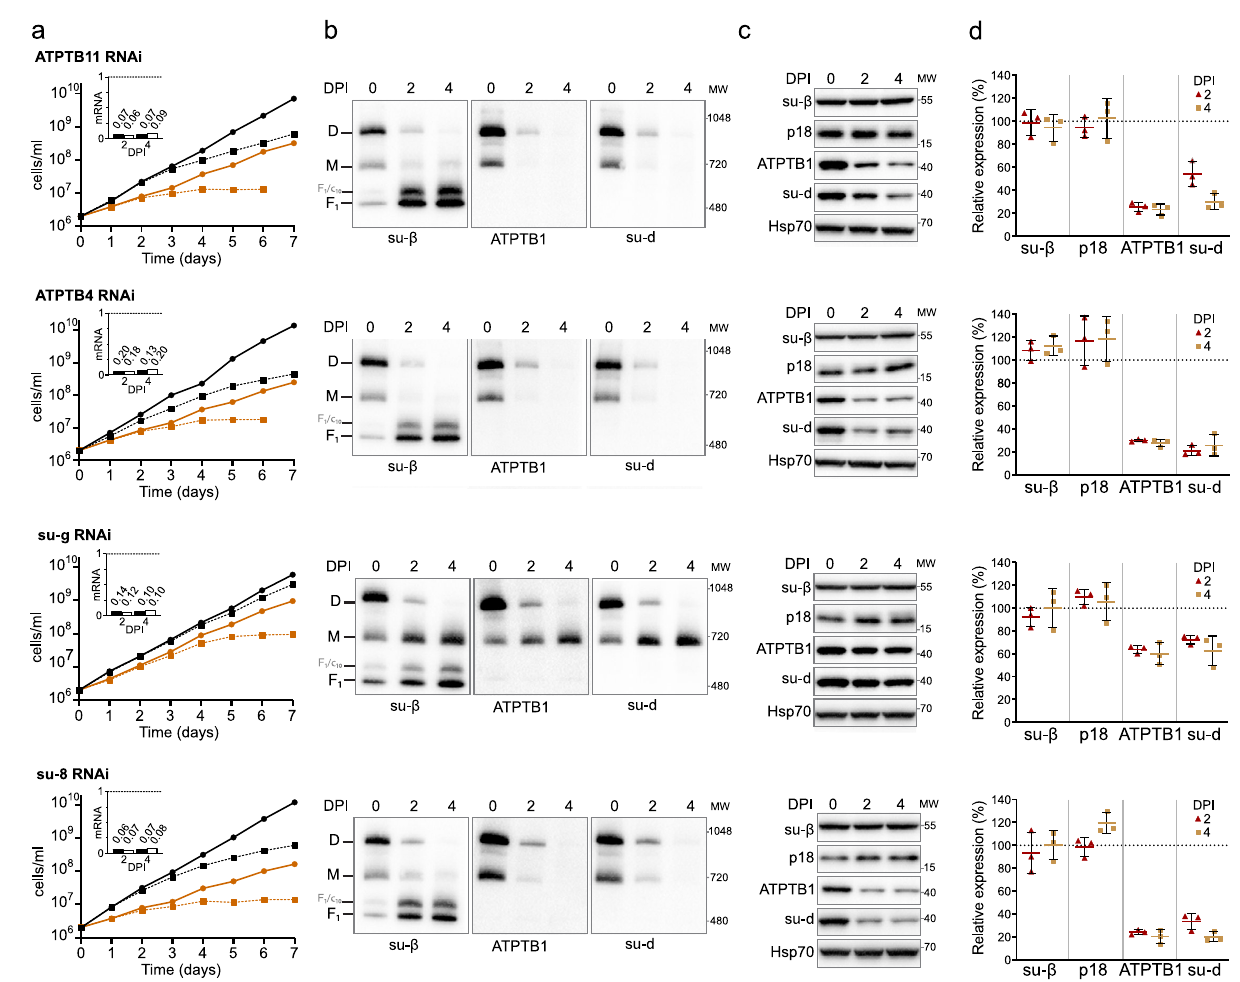
Fig. 6 | RNAi knockdown of subunit- g results in monomerization of ATP synthase. a Growth curves of non-induced (solid lines) and tetracycline-induced (dashed lines) RNAi cell lines grown in the presence (black) or absence (brown) of glucose. The insets show relative levelsof the respective target mRNA atindicated days post-induction (DPI) normalized to the levels of 18S rRNA (black bars) or β - tubulin (white bars). b Immunoblots of mitochondrial lysates from indicated RNAi cell lines resolved by BN-PAGE probed with antibodies against indicated ATP